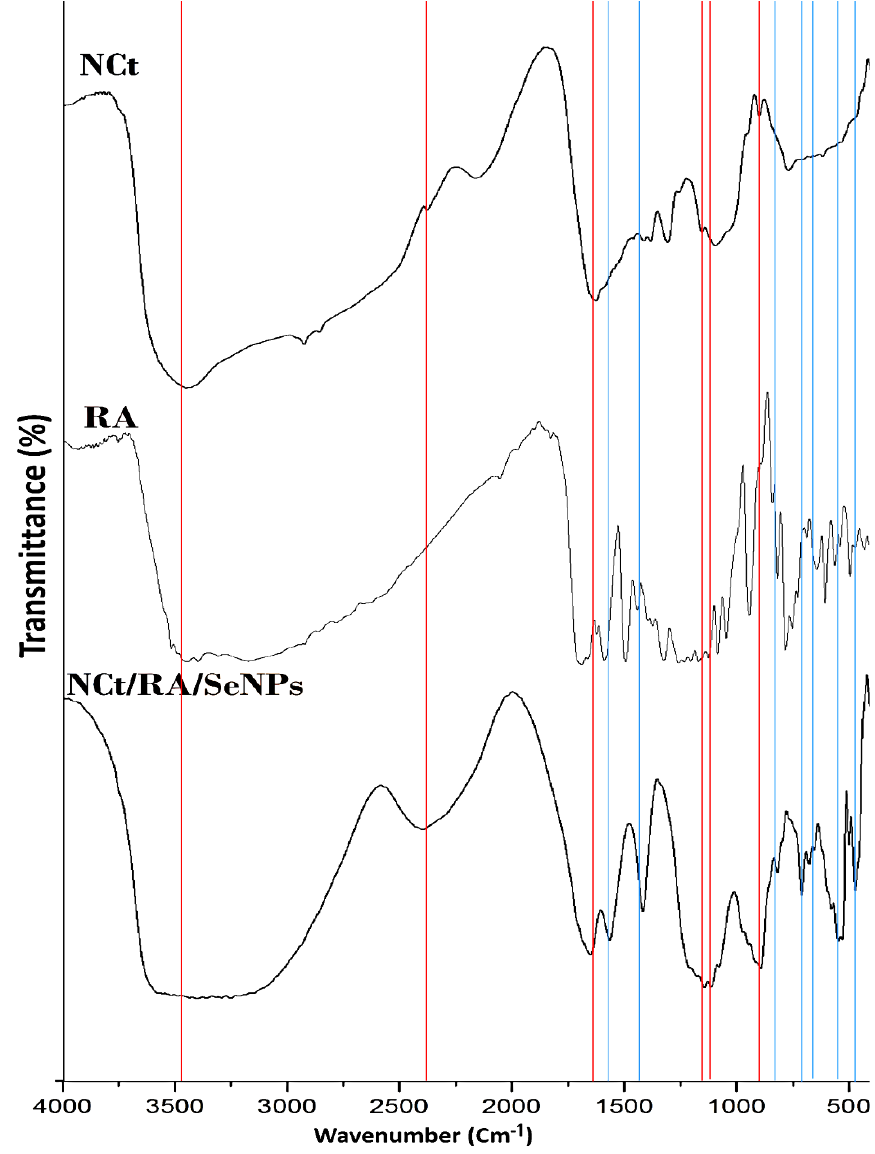
Figure 1. FTIR spectra of screened molecules including chitosan nanoparticles (NCt), rosmarinic acid (RA) and their composites with SeNPs*; * The vertical red lines indicate the derived peaks from NCt and the blue lines indicate the derived peaks from RA.